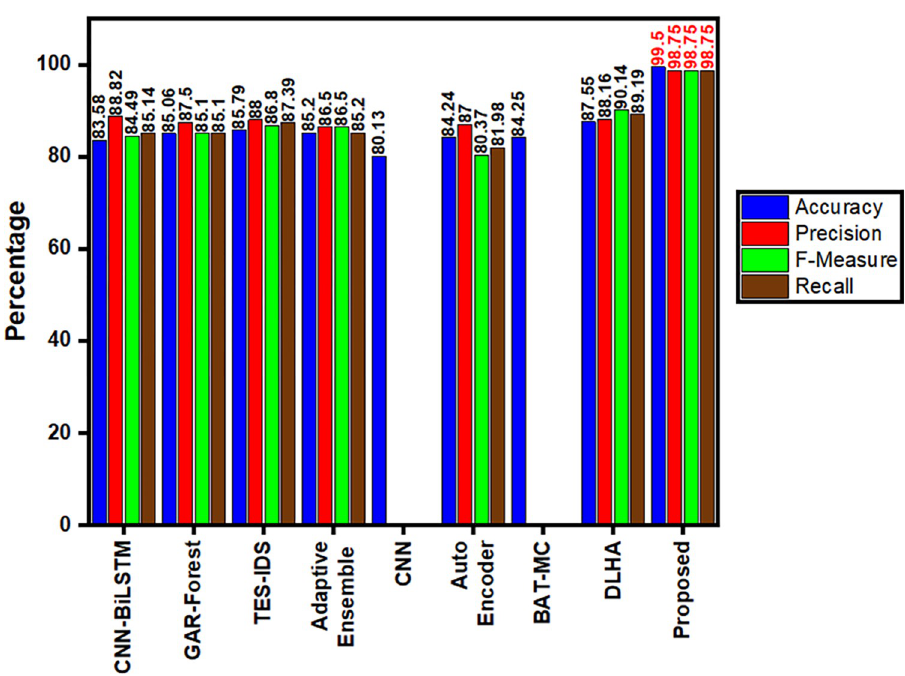
Fig 11. Performance comparison